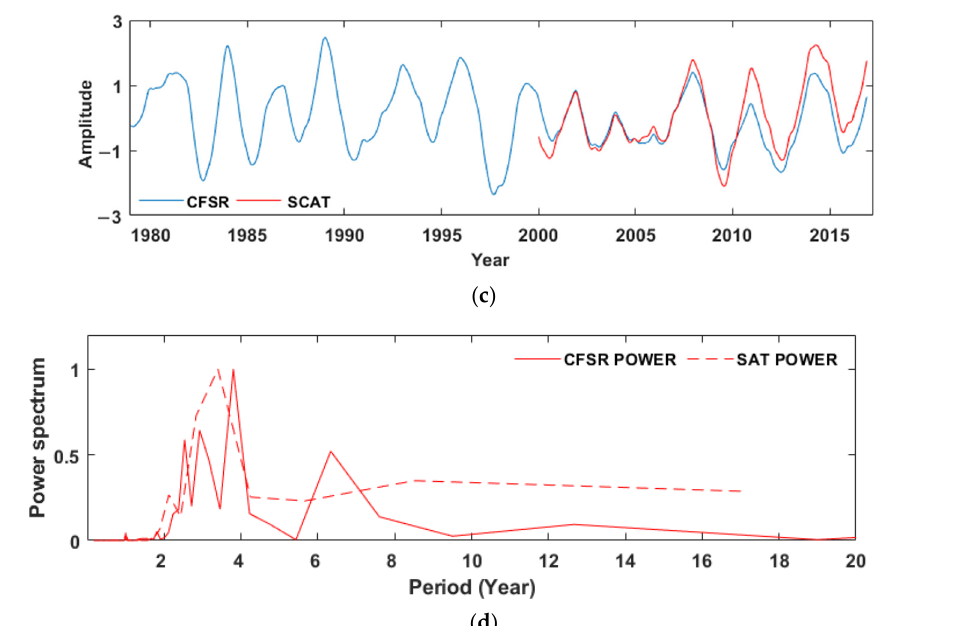
Figure 8. The LVs of CSEOF first mode of scatterometer ( a ) and CSFR ( b ) wind speeds, corresponding PCTS ( c ), and power spectrum density ( d ).